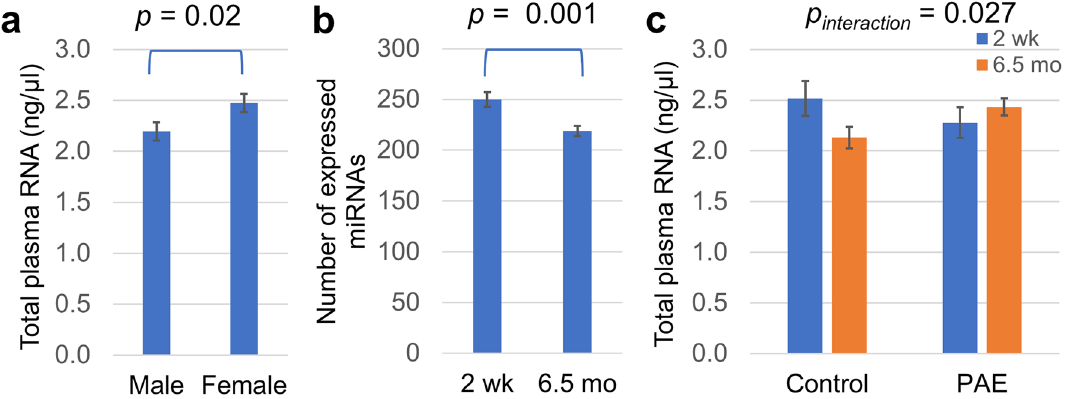
Figure 1. RNA and miRNA content in infant plasma samples. ( a ) Female and male assessed plasma RNA content, determined by multiplying isolated RNA concentration by total plasma volume. ( b ) The total number of expressed plasma miRNAs, i.e., miRNAs with detected CT, at T 2wk and T 6.5mo . ( c ) Association between plasma RNA concentration, PAE status, and infant age. For ( a ) and ( b ), t -test p -values are shown. For ( c ), the p -value shown is for the interaction between age and exposure group resulting from a two-way